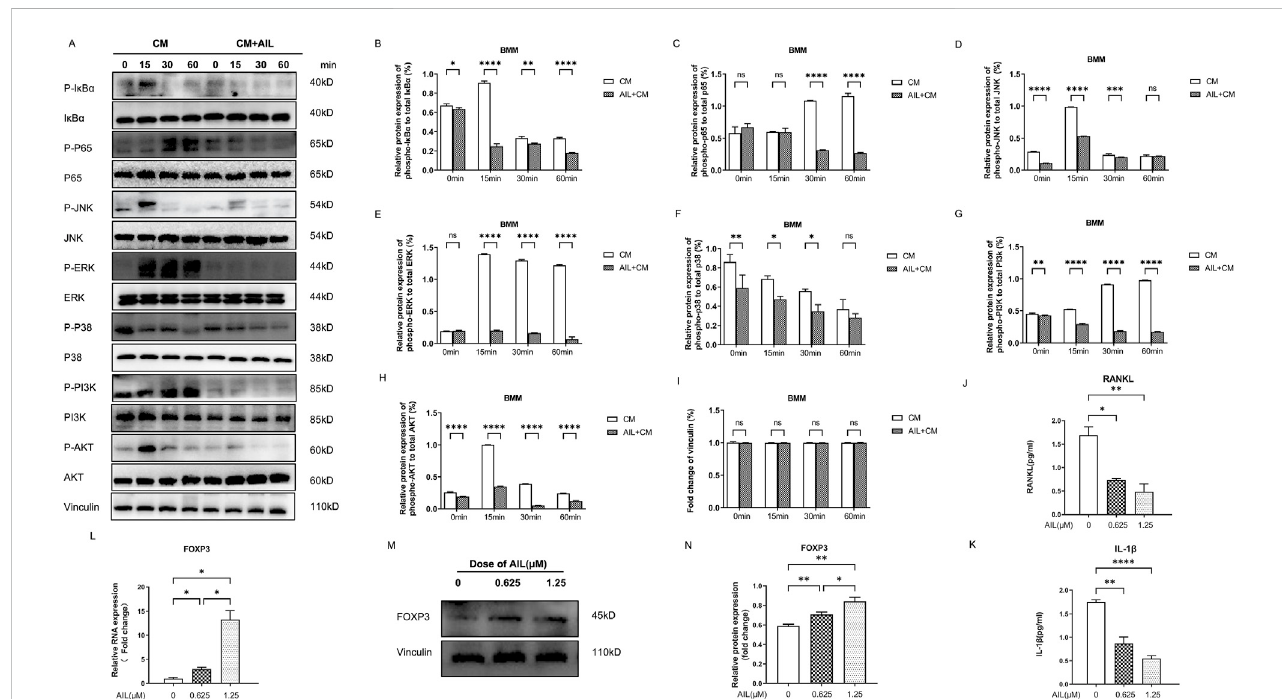
FIGURE 5 AIL inhibits the stimulation of the MAPK, NF- κ B, and PI3K/AKT signaling pathways, induced by MDA-MB-231CM, by suppressing the IL-1 β and RANKL in MDA-MB-231CM. (A) BMM cells were induced to differentiate with AIL (1.25 μ M) treated MDA-MB-231CM, and lysed cells to collect proteins at 0, 15, 30, and 60 min, respectively. The phosphorylation of the major proteins involved in the NF- κ B pathway, including I κ B α and P65, was detected using the Western blotting technique. The phosphorylation of major proteins like AKT and PI3K in the PI3K-AKT signaling pathway, was detected using Western blotting experiments.ThephosphorylationlevelofthemajorproteinsinvolvedintheMAPKpathway,includingJNK,ERK,andP38,weredetectedusingWesternblots. (B – I) Quantitative phosphorylation and total I κ B α , p65, PI3K, AKT, JNK, ERK, and P38 protein expression levels. (J,K) The IL-1 β and RANKL expression levels in thecell-freesupernatantofMDA-MB-231cellstreatedusingdifferingAILconcentrationswereexamined. (L) .WhentheMDA-MB-231cellsweretreatedusing differing concentrations of AIL, RNA was extracted, and the FOXP3 gene expression was upregulated by qPCR analysis. The 2 ^ ΔΔ CT technique was utilized to evaluate the data, and Table 1 provides a list of individual primers used in the study. (M,N) To ascertain the impact of various AIL concentrations on the FOXP3 protein expression levels in the MDA-MB-231 cells and its quanti fi cation, the Western blotting technique was used. The mean ± SD of the three replicates were used to express all the data. * p < 0.05, ** p < 0.01, *** p < 0.0001, **** p < 0.0001, ns – no signi fi cance, in comparison to the